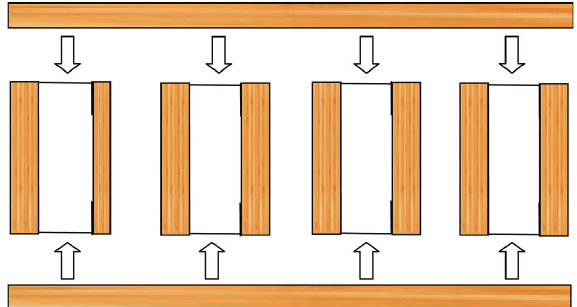
Figure 2: Structure of bamboo steel composite wall.